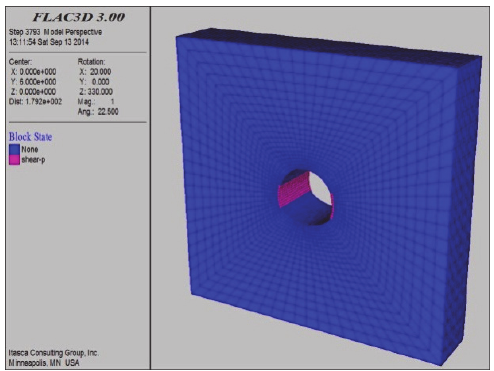
Figure 9: 1d traditional support plastic zone. Figure 10: 1d new support plastic zone.